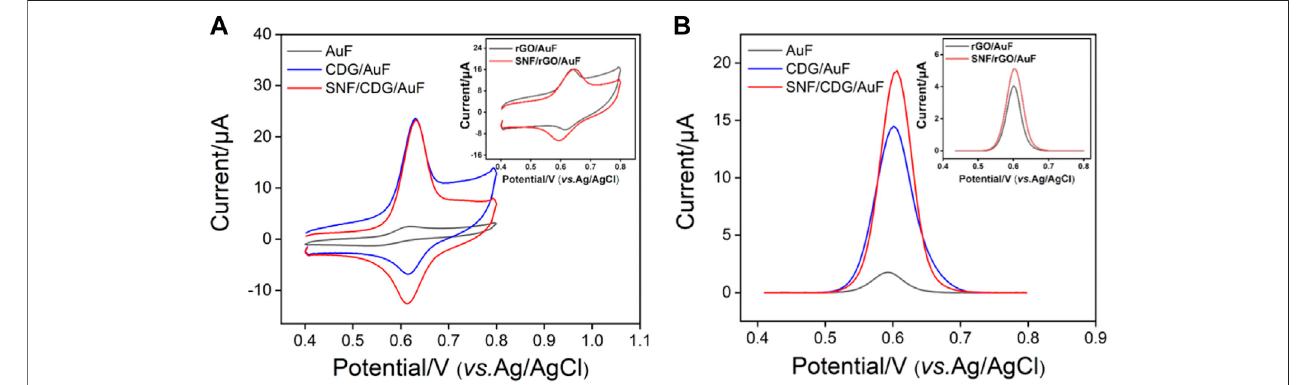
FIGURE5|(A) CVcurvesofAPAP(20 μ M)obtainedonSNF/CDG/AuFin0.1 MPBSatvariouspHvalues. (B) Theplotsofanodicandcathodicpeakpotentialwith pH values. (C) DPV curves and oxidation peak currents (D) measured on SNF/CDG/AuF towards APAP (20 μ M) in 0.1 M PBS (pH 3.0) at different accumulation time.